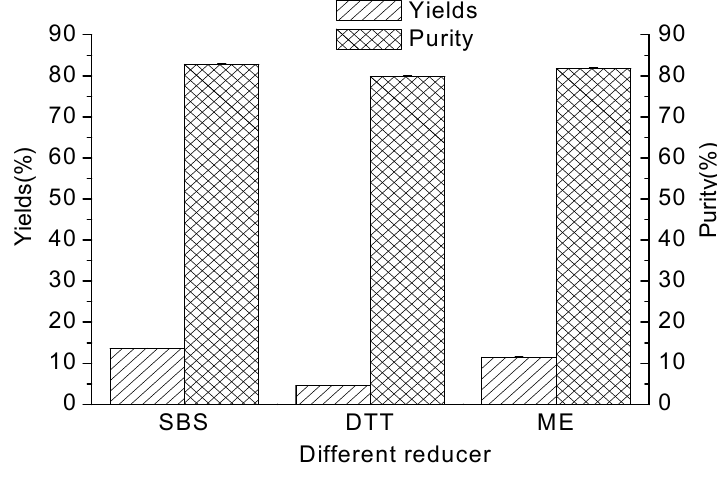
Figure 2. The effect of different kinds of reducing agent on yields and purity of glycinin (11S).